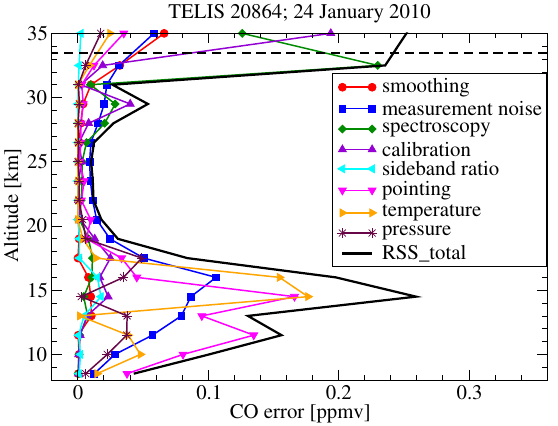
Figure 14. Individual estimates of smoothing, noise, and model parameters errors for the CO retrieval. The estimated errors correspond to TELIS FIR measurement 20864 during the 2010